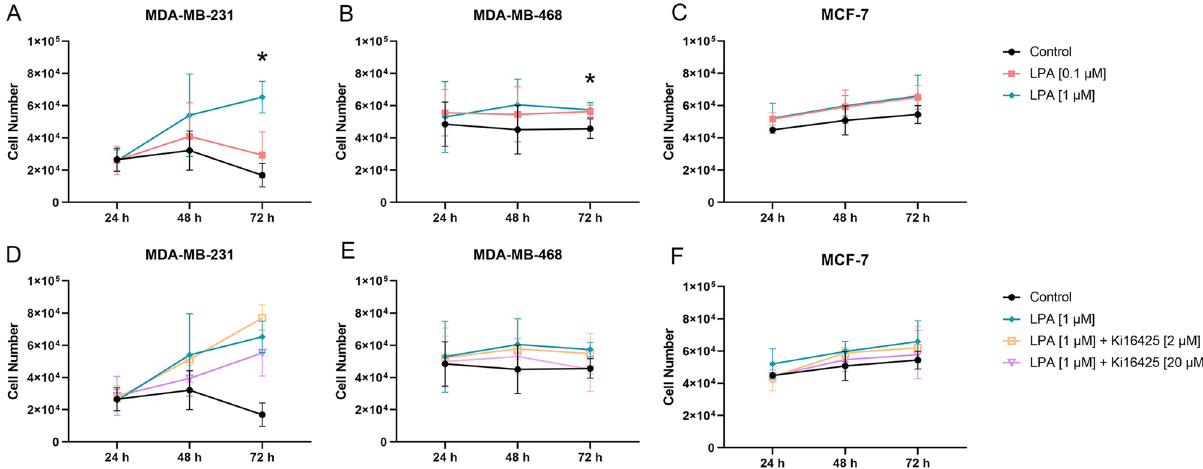
Figure 1. CyQUANT proliferation assay of breast cancer cells. Effect of lysophosphatidic acid (LPA) 18:1 and the LPA receptor 1, 3 (and 2) inhibitor Ki16425 on proliferation of MDA-MB-231, MDA-MB-468 and MCF-7 cell lines after 24 h, 48 h, and 72 h. (A–C) Data points show the absolute number of living cells per well (y-axis) with the addition of varying concentrations of LPA compared to the control group for several time points (x-axis). (D–F) Data points show the absolute number of live cells per well (y-axis) with the addition of 1.0 µM LPA and Ki16425 in varying concentrations as well as the control group for several time points (x-axis). n = 3 replicate experiments, values are presented as mean ± SD. *: p ≤ 0.05 compared to the control group (Kruskal– Wallis test and post-hoc Dunn’s